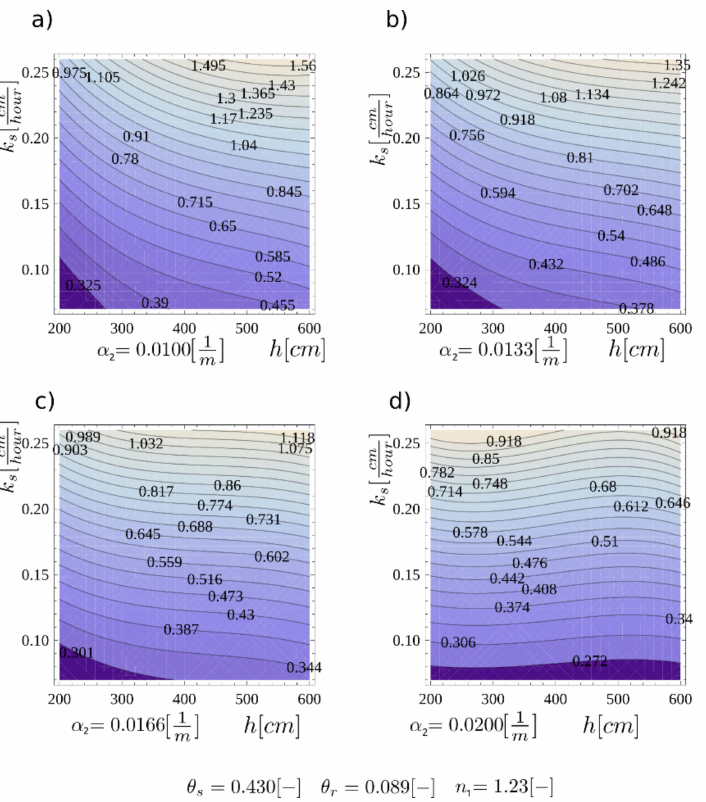
Figure 12. The velocity of the wetting head v F for four cases of the soil water retention function parameter: ( a ) α 2 = 0.0100 cm − 1 ; ( b ) α 2 = 0.0133 cm − 1 ; ( c ) α 2 = 0.0166 cm − 1 ; ( d ) α 2 = 0.0200 cm − 1